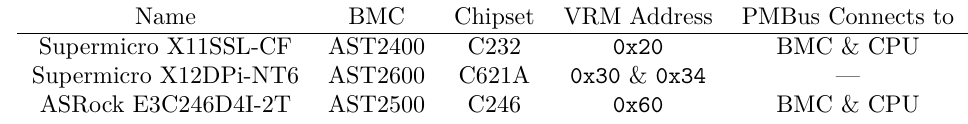
Table 3: Tested motherboards and their VRM detection